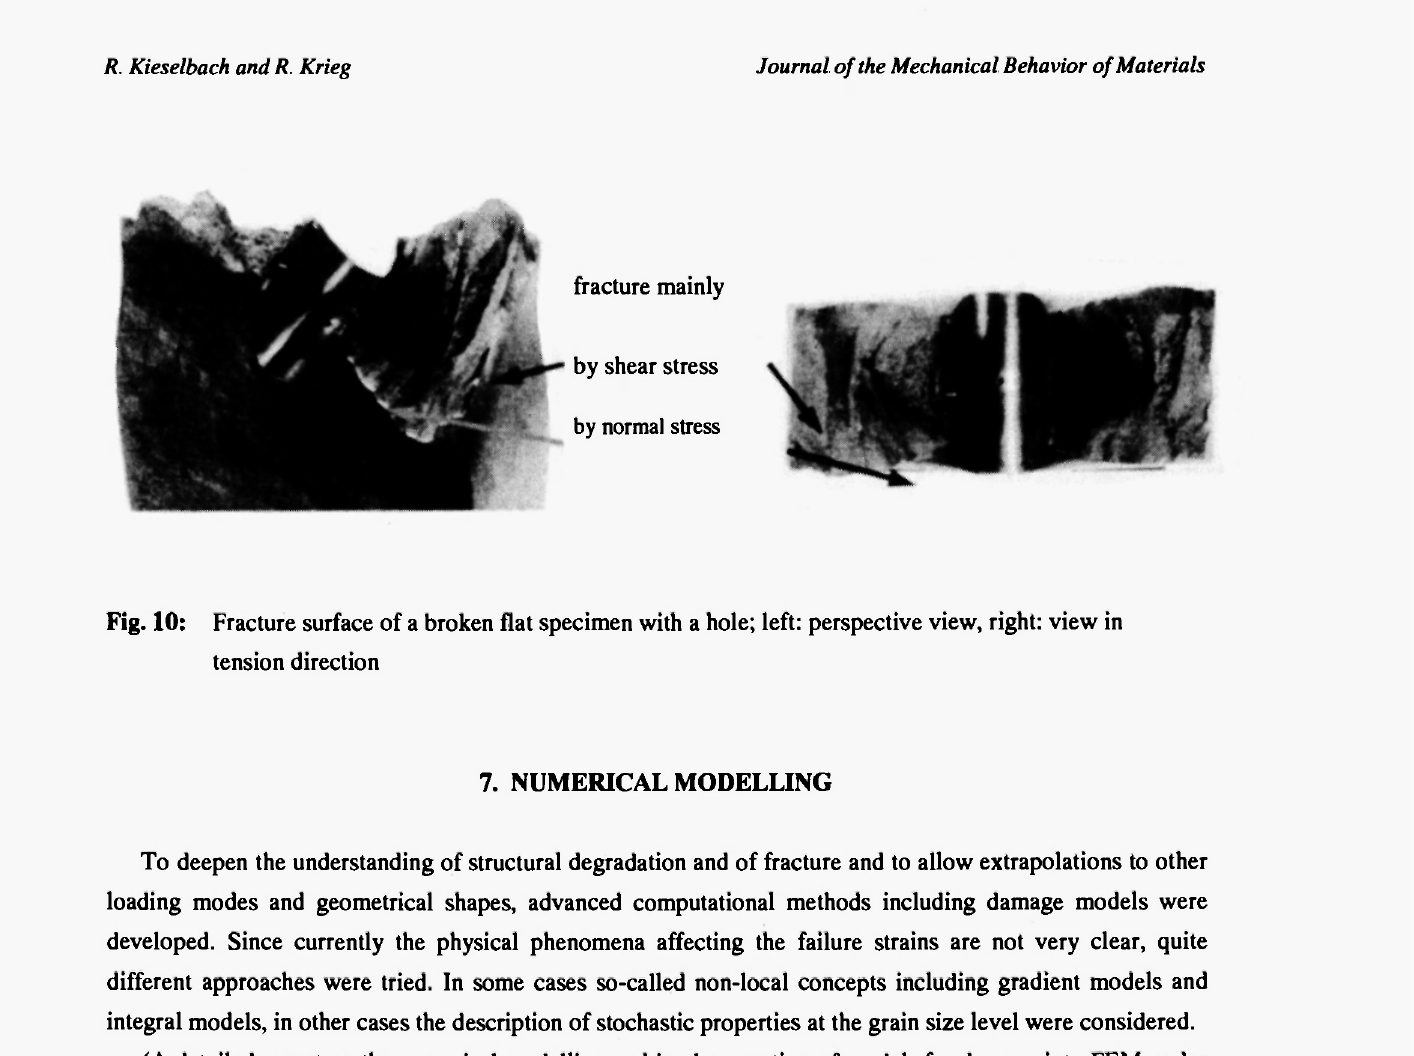
Fig. 10: Fracture surface of a broken flat specimen with a hole; left: perspective view, right: view in tension